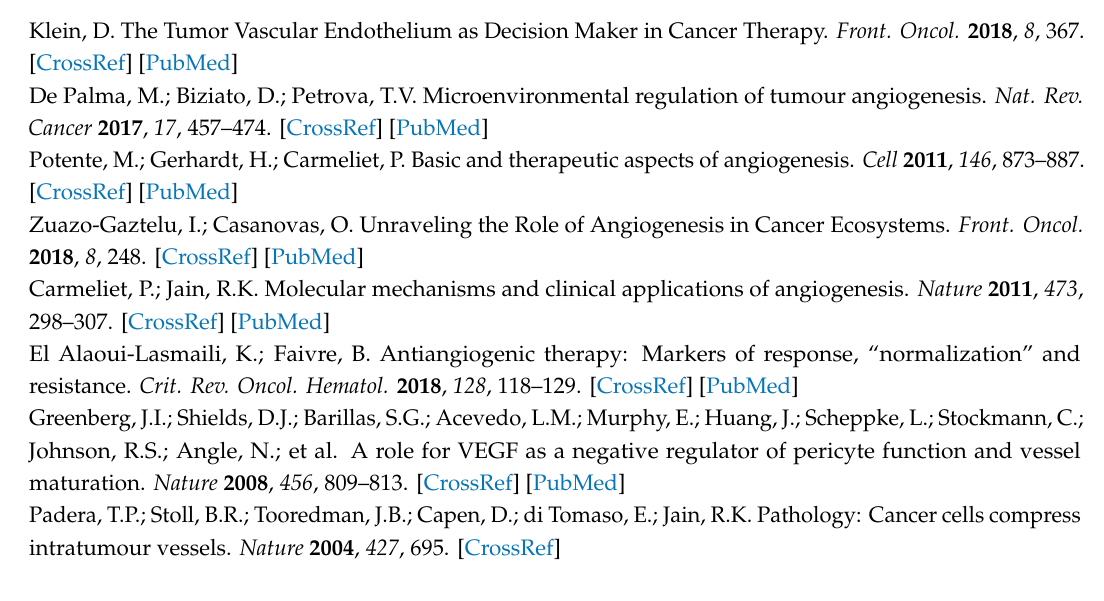
Figure S1: ( A ) Levels of SDC1 and B-FN in the conditioned culture medium of SKOV3, OS13 and OS2 at 48 h. ( B ) Surface expression of SDC1 on SKOV3 and OS13 decreases at 24 h in presence of bFGF and VEGF. Percentage of positive cells are reported. List of antibodies used in FCM and IF. Table S1: List of antibodies used in FCM and IF, Table S1: List of antibodies used in FCM (flow cytometry) and IF